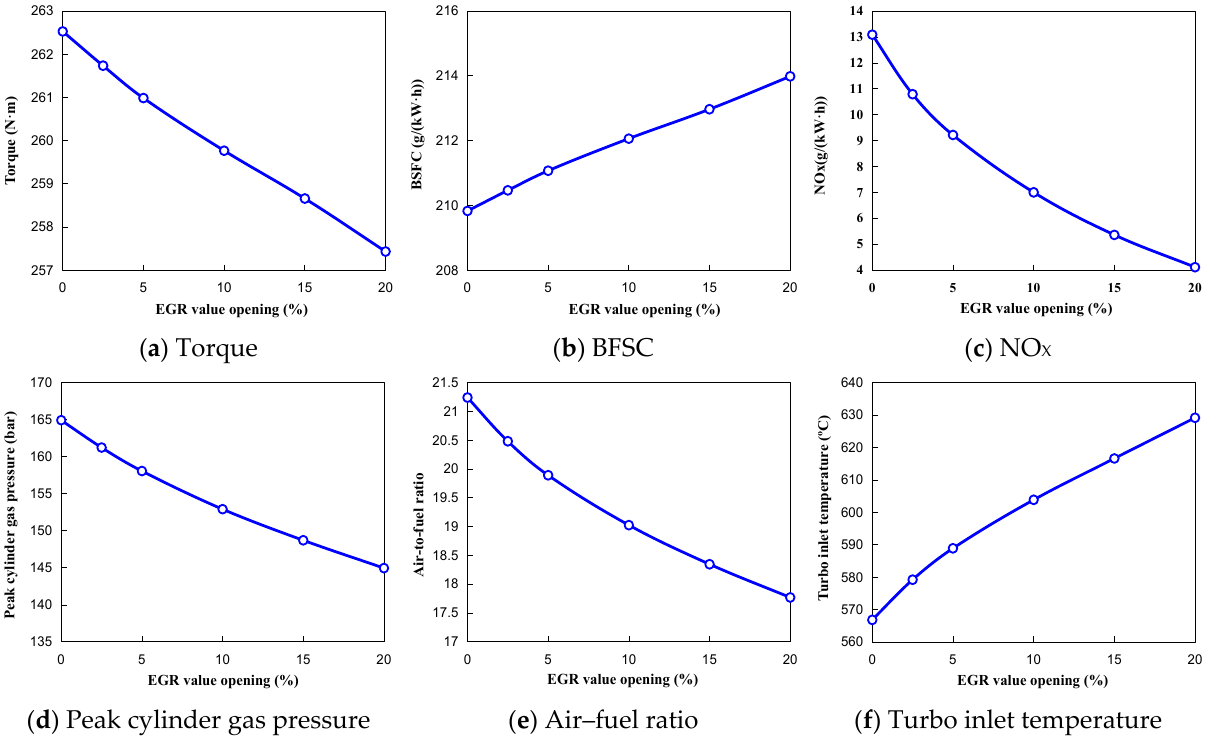
Figure 8. Effects of the EGR value opening on the performance and emission of a diesel